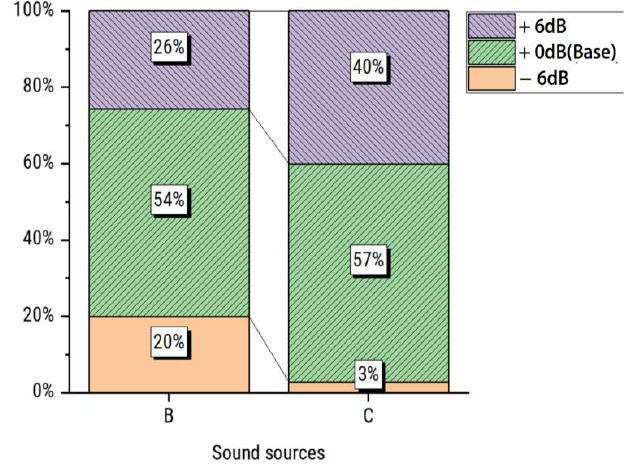
Figure 6. Subjective noise intensity results: (Source B) before applying masking technology (Source C); after applying masking technology.